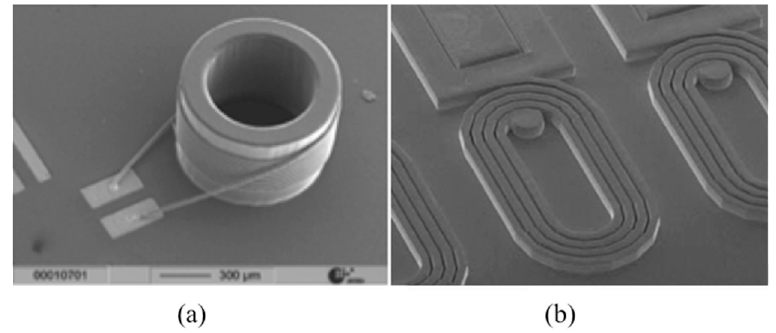
Figure 3. NMR μ Coil techniques ( a ) Vertical μ Coil and ( b ) planer μ Coil. Figure 3. NMR µ Coil techniques ( a ) Vertical µ Coil [25] and ( b ) planer µ Coil